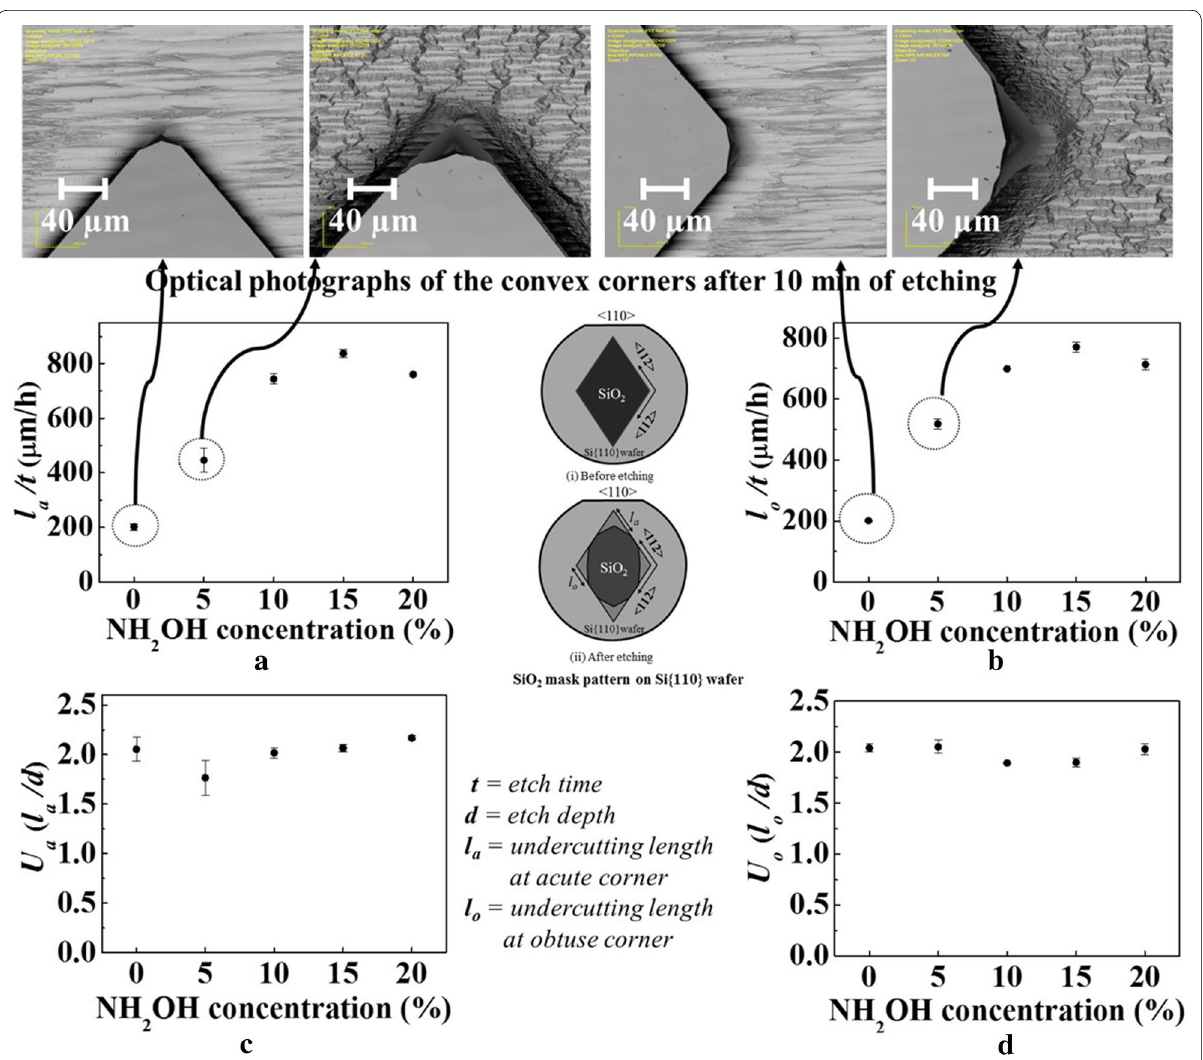
Fig. 6 Undercutting at acute and obtuse corners of a rhombus shape structure formed by ⟨ 112 ⟩ directions on Si{110} wafer in pure and various concentrations of NH 2 OH-added 20 wt% KOH solution: undercutting rate ( l/t ) at a acute and b obtuse corners; undercutting ratio ( l/d ) at c acute and d obtuse